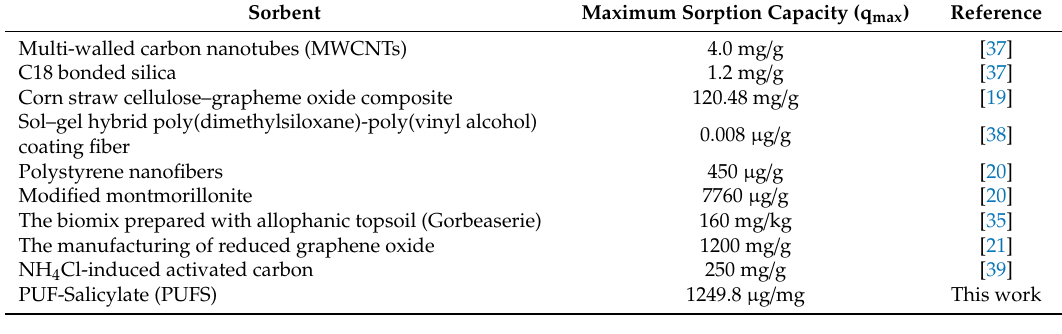
Table 3. Comparison of Maximum Sorption Capacities of Chlorpyrifos Removal.